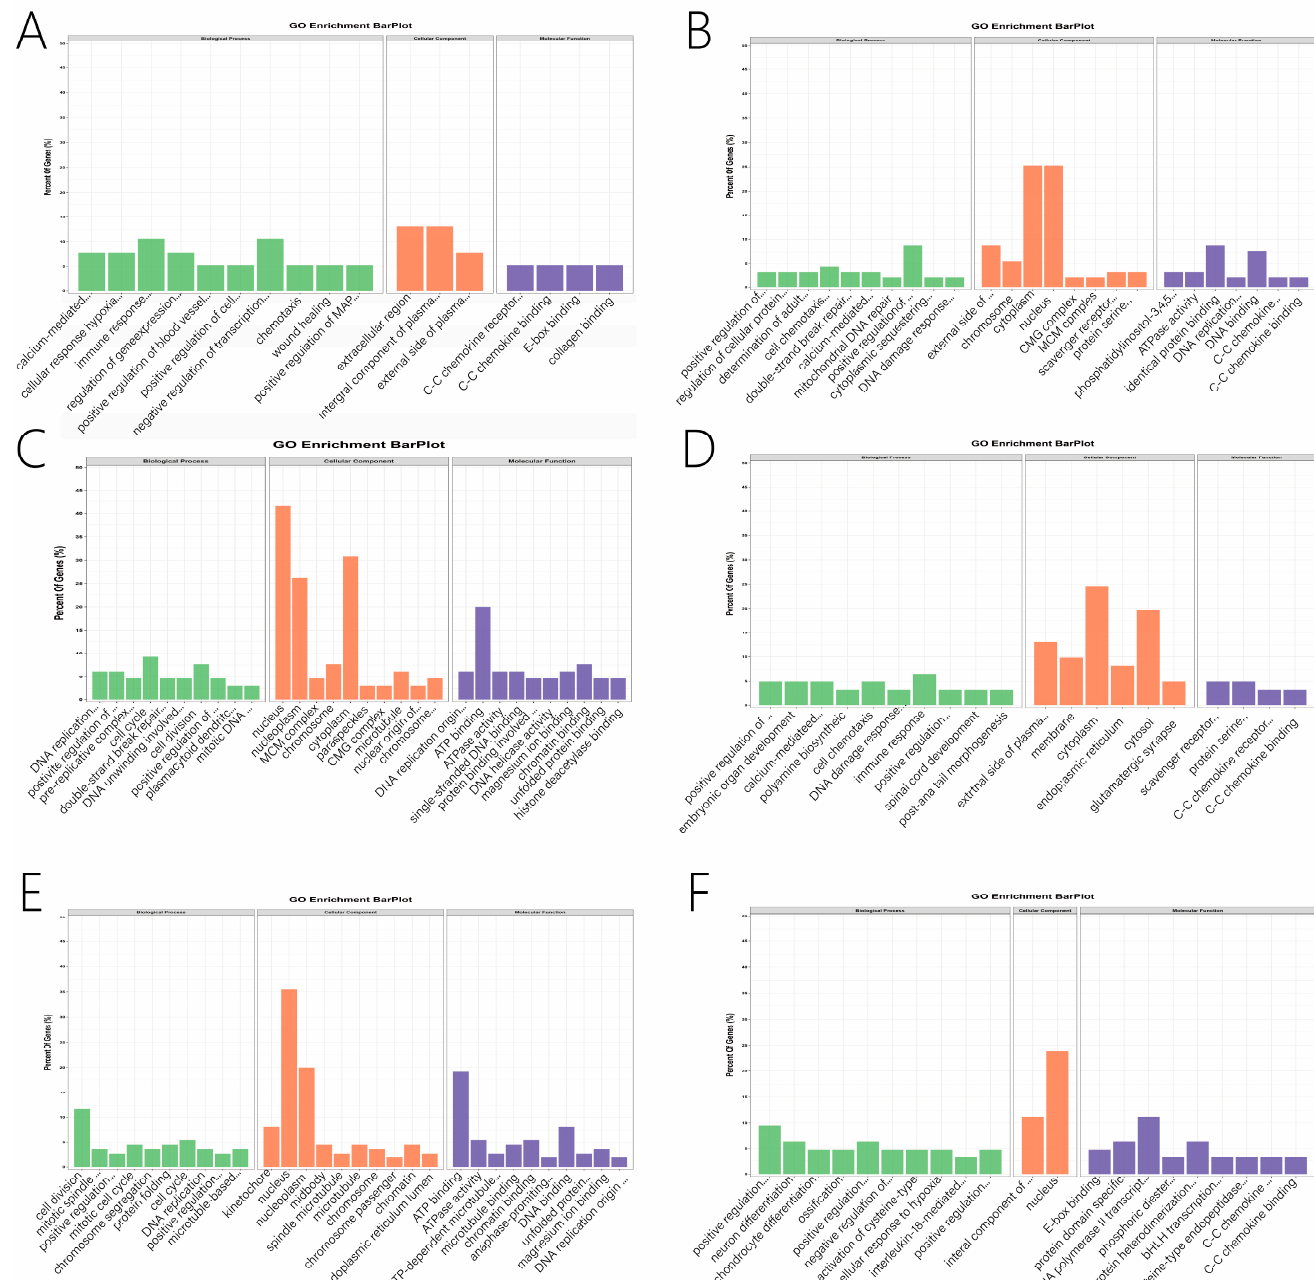
Figure 6. Analysis of gene ontology (GO) enrichment in related Specific module genes, the green part represents BP (Biological Process), the orange part represents CC (Cellular Component), and the purple part represents MF (Molecular Function). ( A ) GO enrichment analysis of genes in N-light cyan module. ( B ) GO enrichment analysis of genes in N-midnight blue module. ( C ) GO enrichment analysis of genes in N-light green module. ( D ) GO enrichment analysis of genes in the N-grey module. ( E ) GO enrichment analysis of genes in M-light green module. ( F ) GO enrichment analysis of genes in M-light cyan module.